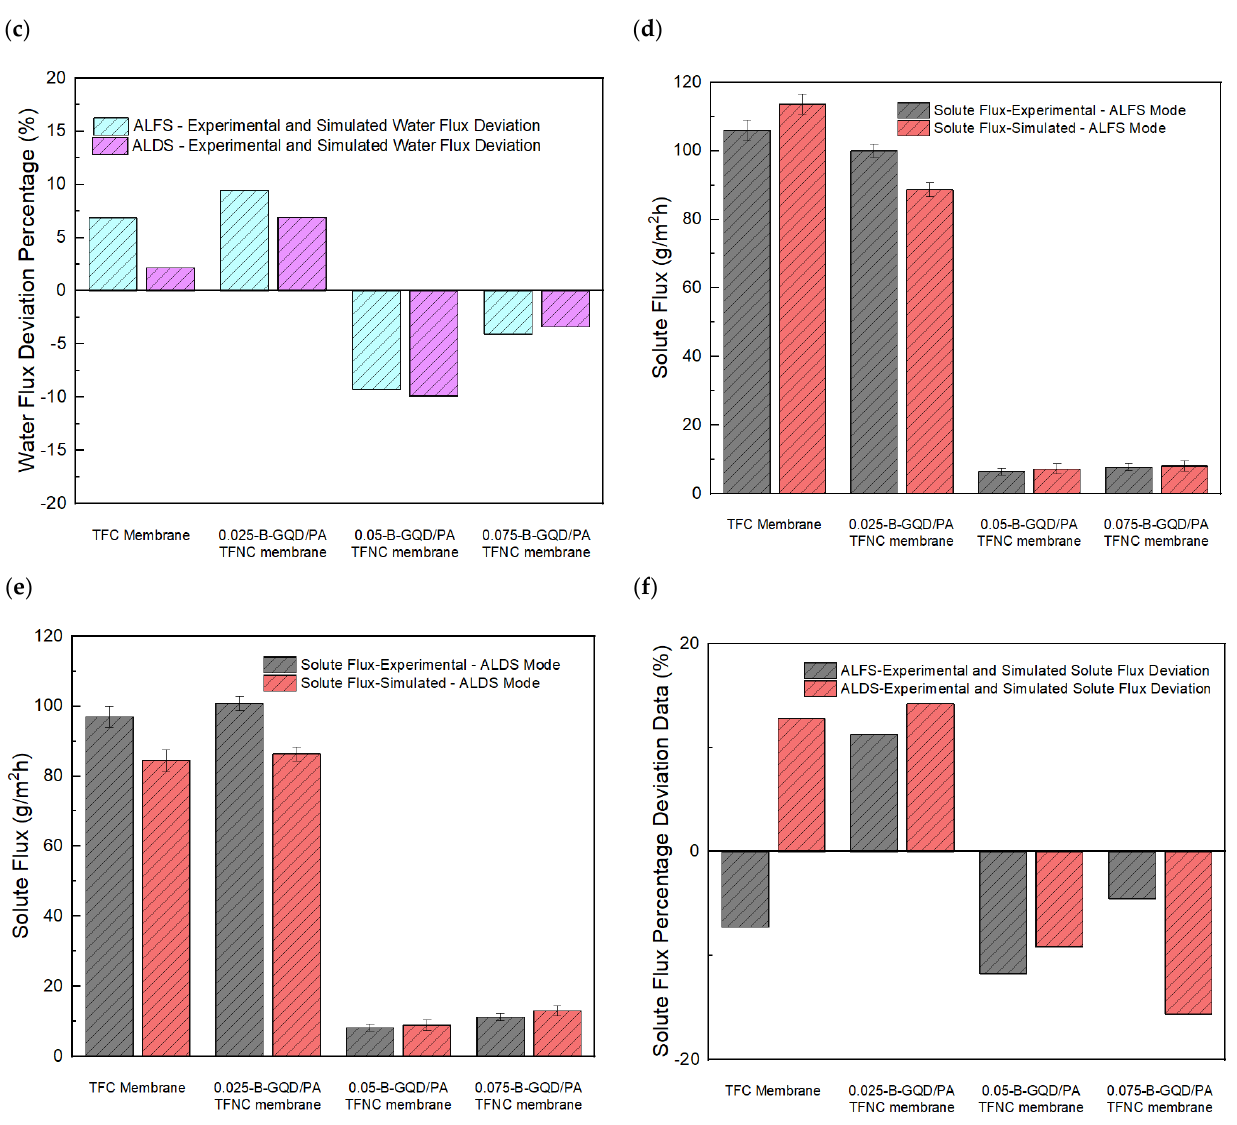
Figure 14. ( a ) AL-FS mode experimental and simulated water flux; ( b ) AL-DS mode experimental and simulated water flux; ( c ) AL-FS and AL-DS mode experimental and simulated water flux percentage Figure 14. ( a ) AL − FS mode experimental and simulated water flux; ( b ) AL − DS mode experimental deviation; ( d ) AL-FS mode experimental and simulated solute flux; ( e ) AL-DS mode experimental and simulated water flux; ( c ) AL − FS and AL − DS mode experimental and simulated water flux per- centage deviation; ( d ) AL − FS mode experimental and simulated solute flux; ( e ) AL − DS mode ex- and simulated solute flux; ( f ) AL-FS and AL-DS mode experimental and simulated solute flux perimental and simulated solute flux; ( f ) AL − FS and AL − DS mode experimental and simulated percentage solute flux percentage deviation.